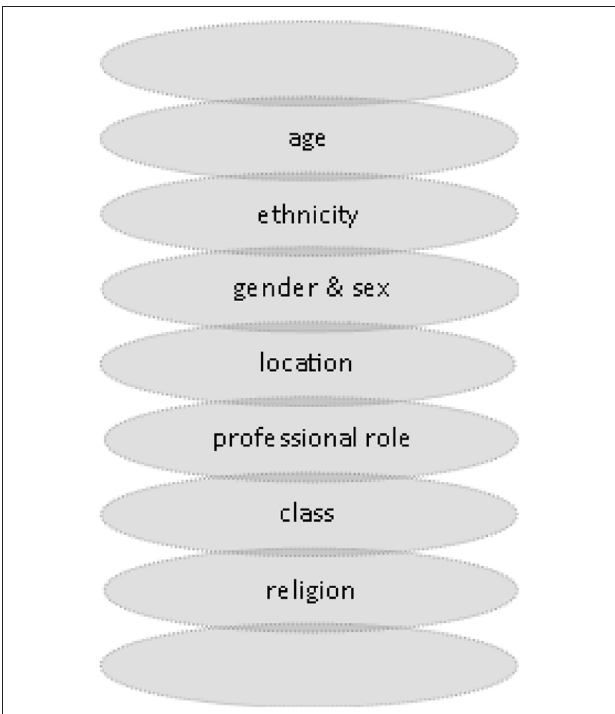
FIGURE 2 | Saeeda’s identity model of simultaneity (adapted from Holvino, 2005). Permission received for reprint and adaptions from Evangelina Holvino.